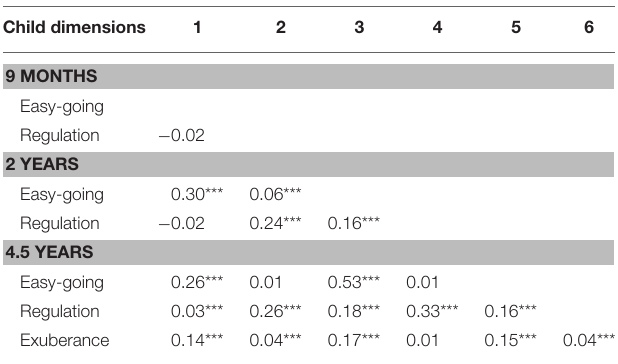
TABLE 6 | Showing pearson correlations between socio-emotional competence index score at each DCW ( N = 4839). Socio-emotional competence index score at each DCW